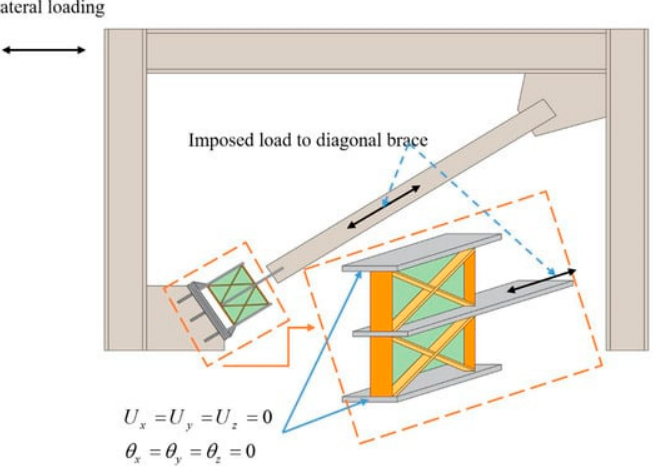
Figure 10. A new MD that improves the behavior of the shear dampers [129].